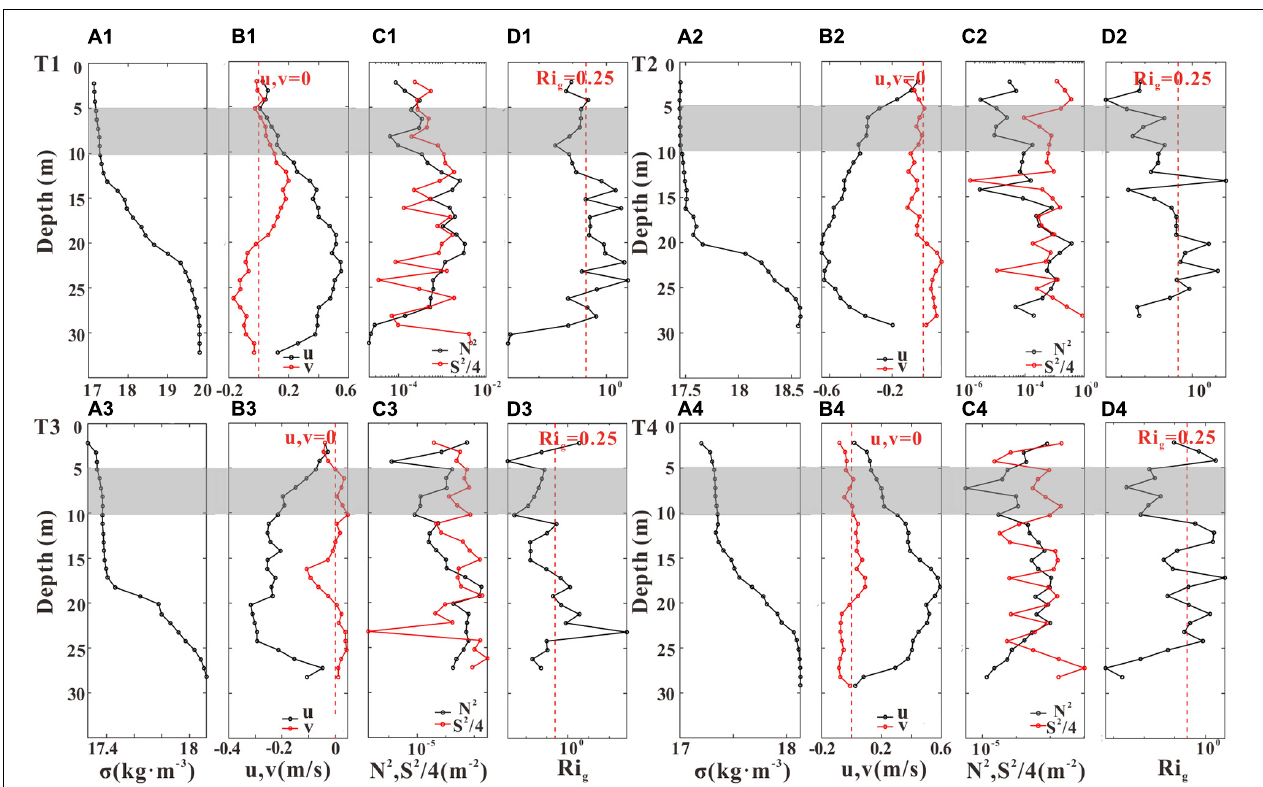
FIGURE 12 | The profiles of density anomaly σ (A1–A4) , u (black line) and v (red line) (B1–B4) , the square of buoyancy frequency N 2 (black line) and the square of velocity shear S 2 /4 (red line) (C1–C4) , and the gradient Richardson number Ri g (D1–D4) during the four representative periods T1–T4 at GJ-01. The red dashed lines indicate u ( v ) = 0 in panels (B1–B4) , and Ri g = 0.25 in panels (D1–D4) , respectively. The shaded parts represent the subsurface (5–10 m)